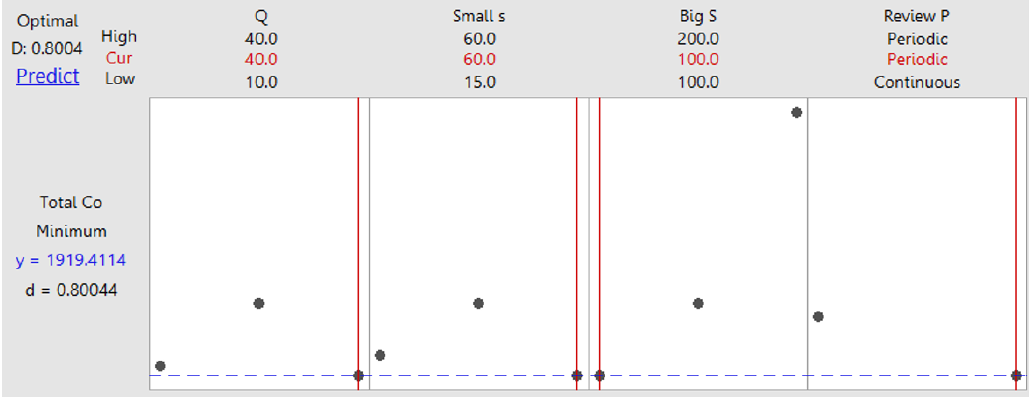
Figure 14. Optimization parameters of full factorial design.